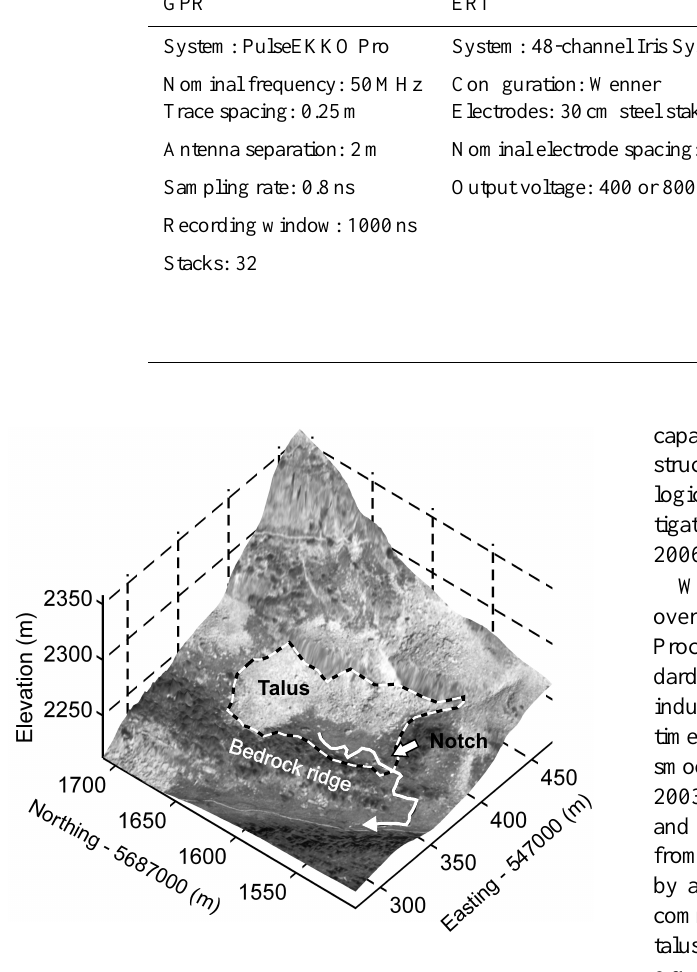
Fig. 2. Three-dimensional photo-draped digital elevation model of the talus-meadow complex (outlined by dashed line). White line – small stream that flows intermittently across the meadow and drains into a neighboring gully. No vertical exaggeration. Coordinates are in UTM